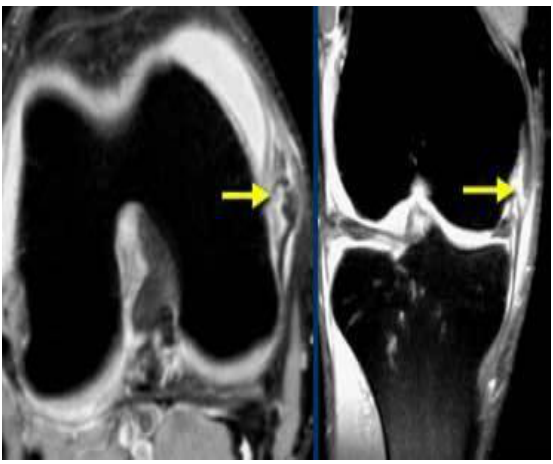
Figure 1: MRI of MCL tear